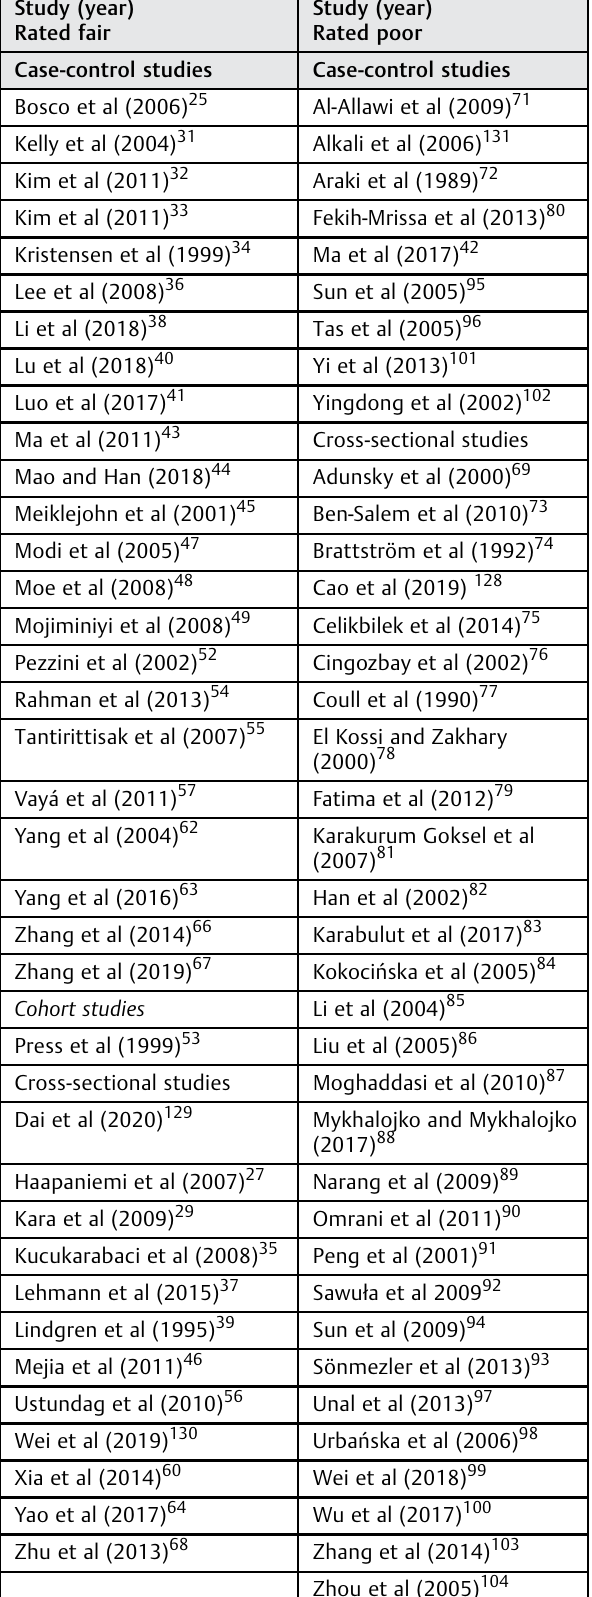
Table 4 Rating of individual studies that did not include a